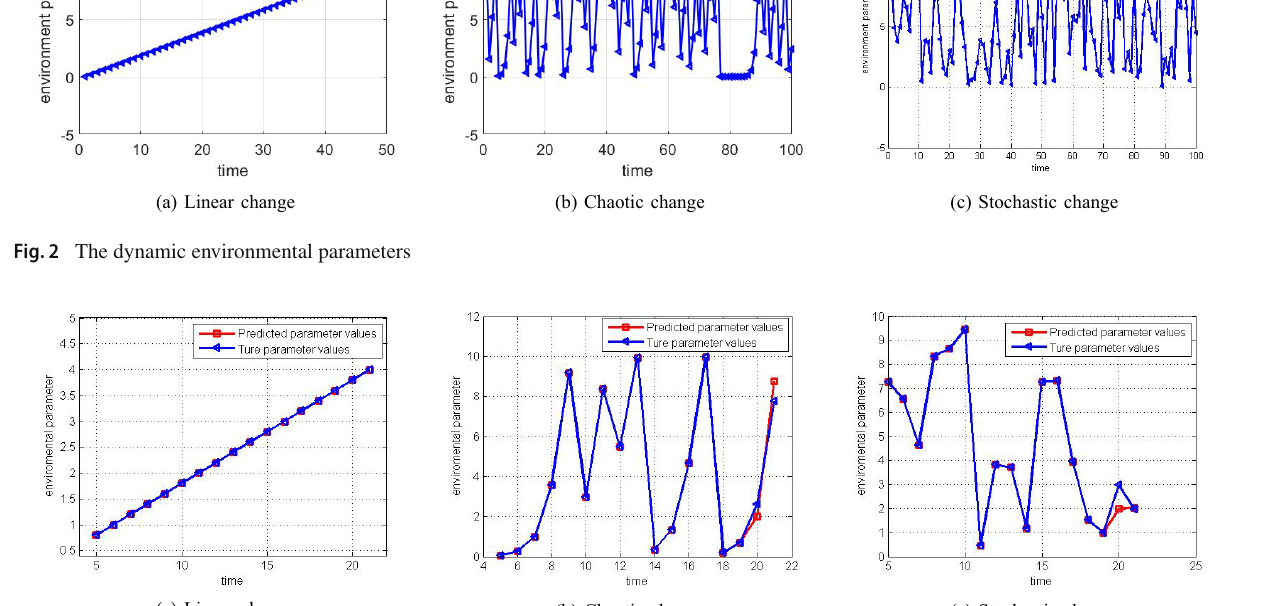
Fig. 3 Comparison of the estimated environmental